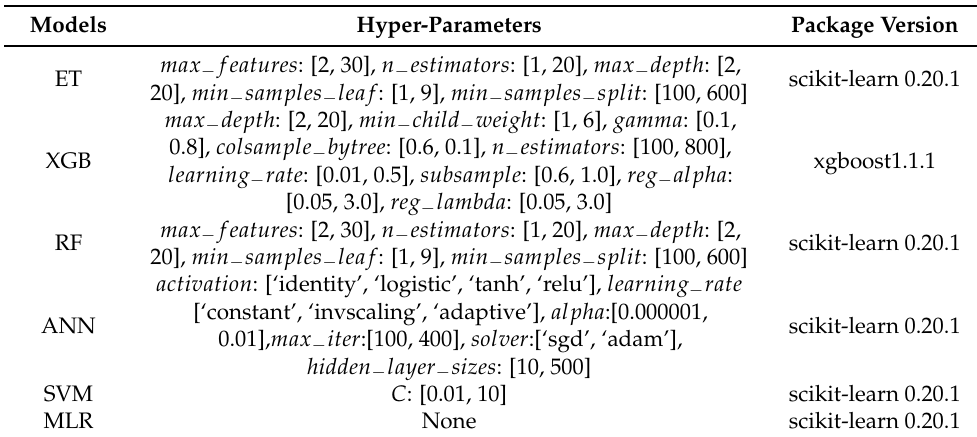
Table 5. Hyper-parameters that need to be optimized.